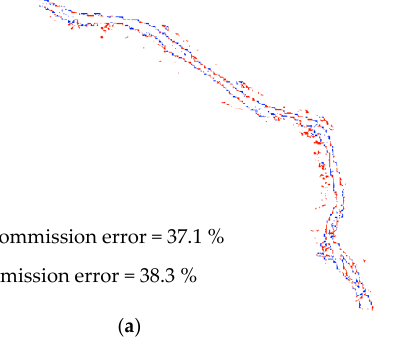
Figure 19. Error maps of ( a ) hard classification and ( b ) sub-pixel map obtained from MBPS for a segment of the Sarca River using the WV-3 image with ZF = 6; red and blue pixels show erroneously committed and omitted water pixels, respectively.